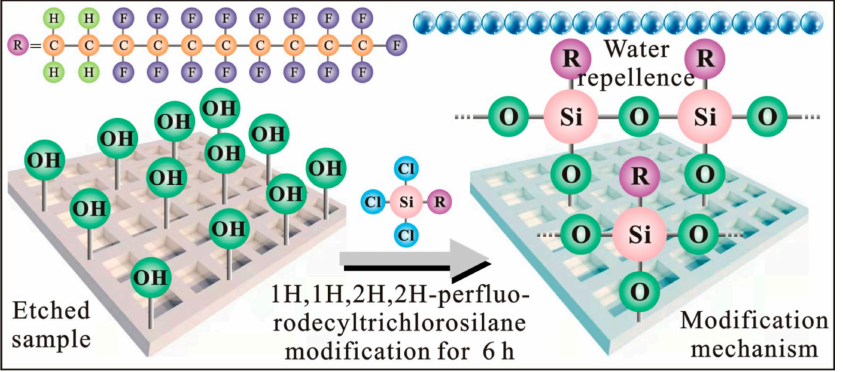
Figure 7. Low-surface-energy modification mechanism on the 7075 alloy surface.